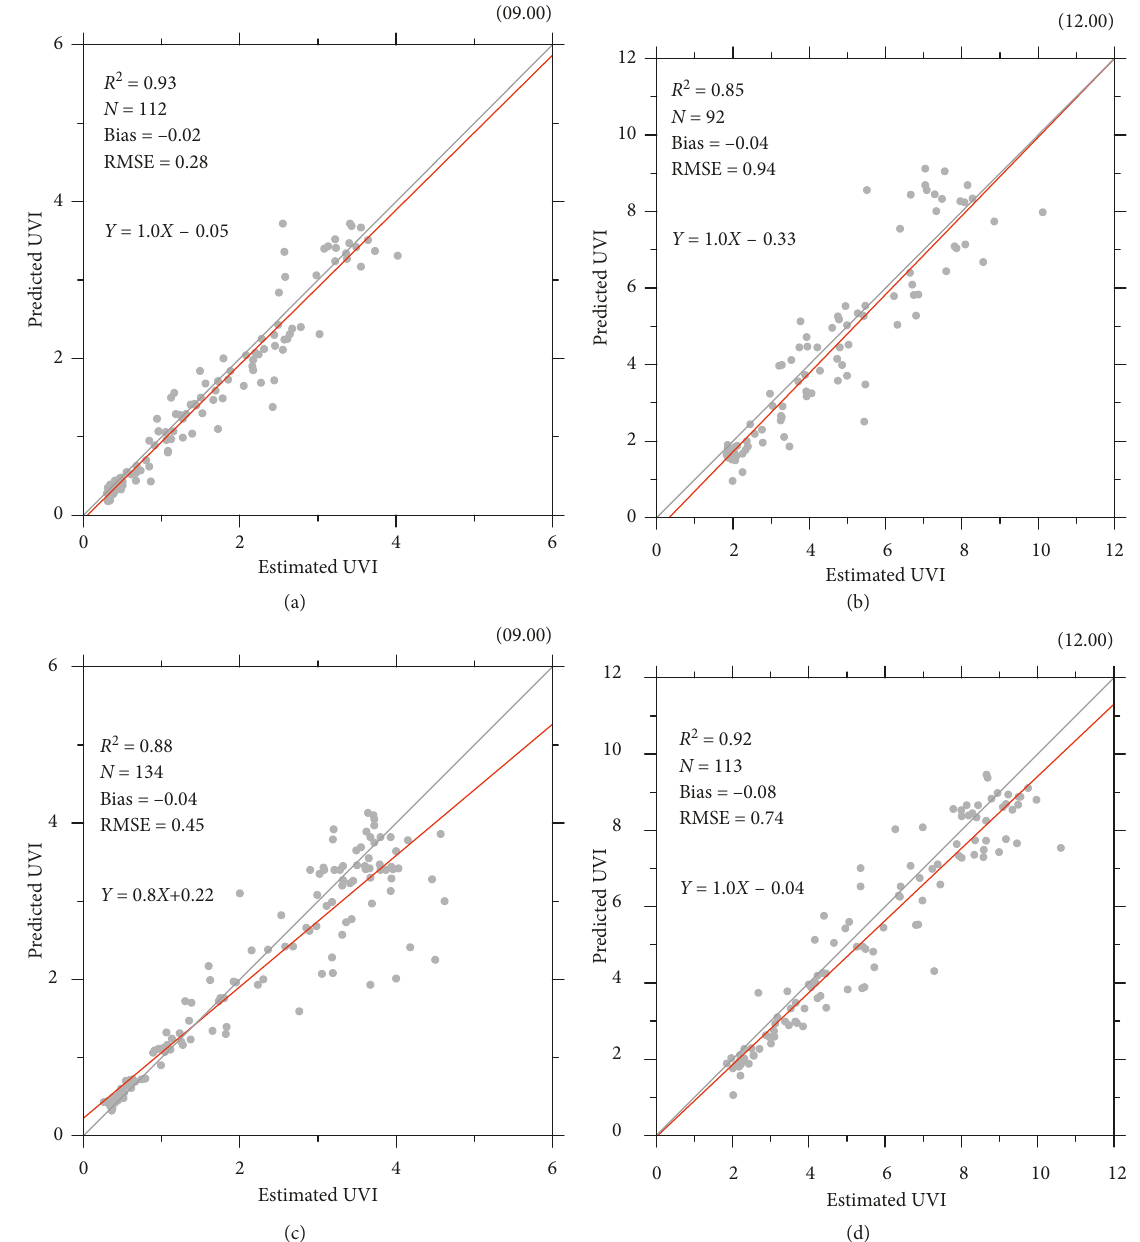
Figure 8: Scatter plot of UVI between the observation and simulation (Predicted UVI) based on cloud-free conditions in (a) Seoul at 9 a.m. and (b) at noon and in (c) Pohang at 9 a.m. and (d) at